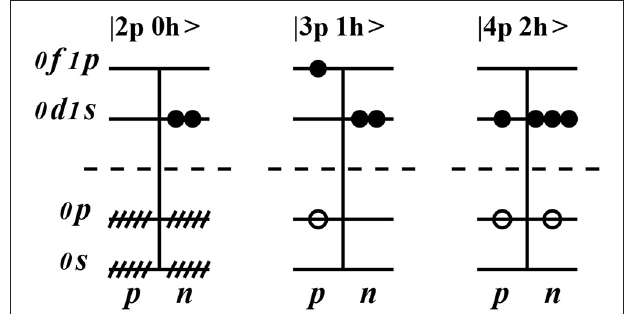
FIGURE 2 | Some 18 O shell-model configurations.